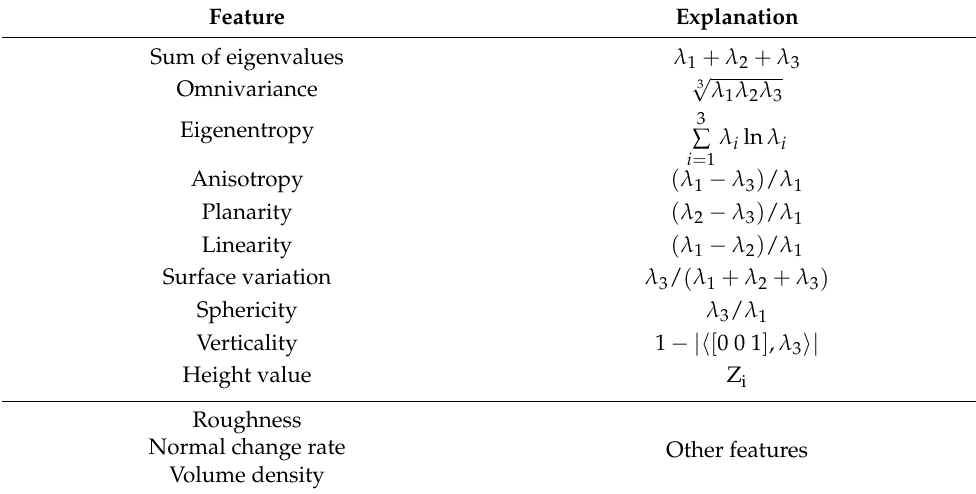
Table 2. Geometric features used in the